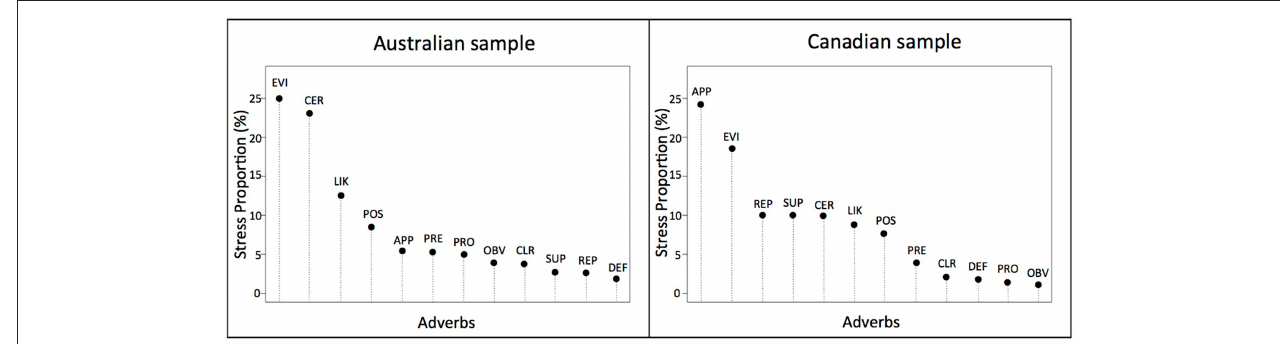
FIGURE 5 | Stress decomposition per adverb (percent contribution to overall stress by each adverb) in each of the Australian and Canadian data sets. The abbreviations for the 12 target adverbs are: APP, apparently; CER, certainly; CLR, clearly; DEF, definitely; EVI, evidently; LIK, likely; OBV, obviously; POS, possibly; PRE, presumably; PRO, probably; REP, reportedly; and SUP,